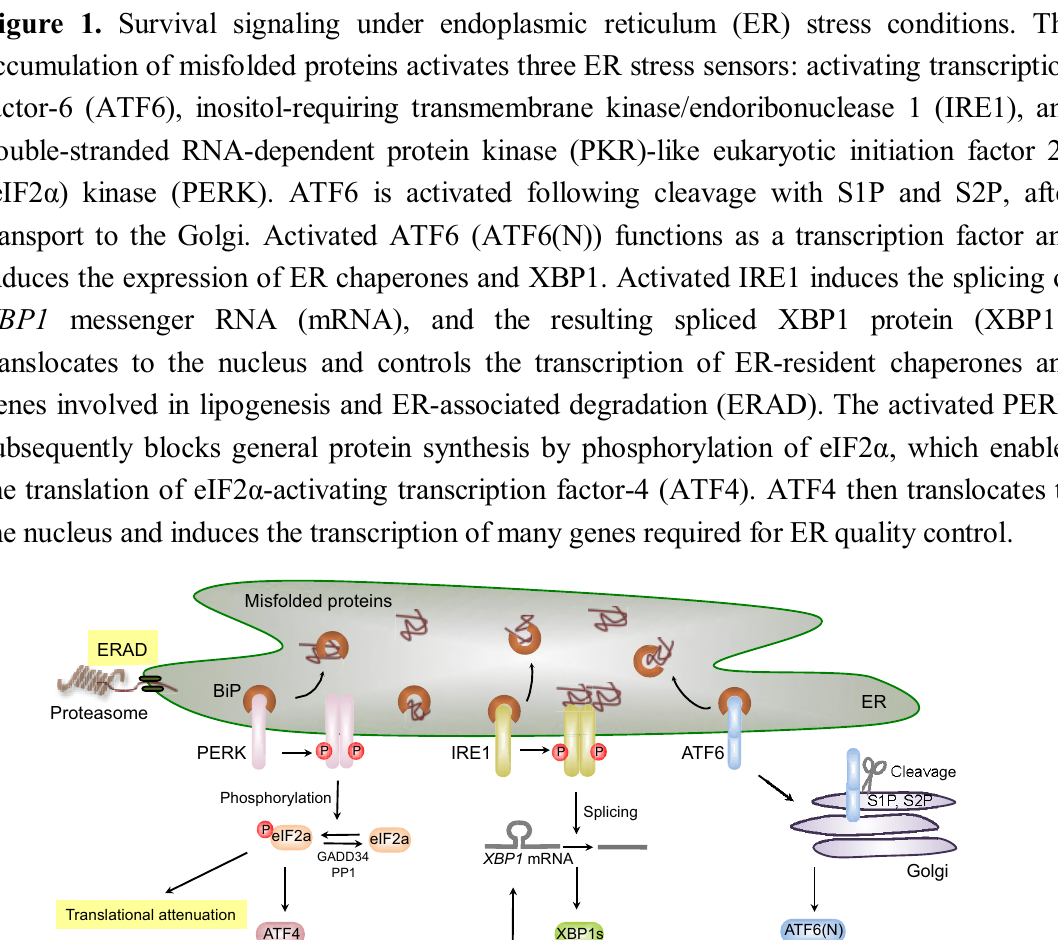
Figure 1. Survival signaling under endoplasmic reticulum (ER) stress conditions. The accumulation of misfolded proteins activates three ER stress sensors: activating transcription factor-6 (ATF6), inositol-requiring transmembrane kinase/endoribonuclease 1 (IRE1), and double-stranded RNA-dependent protein kinase (PKR)- (cid:79)(cid:76)(cid:78)(cid:72)(cid:3) (cid:72)(cid:88)(cid:78)(cid:68)(cid:85)(cid:92)(cid:82)(cid:87)(cid:76)(cid:70)(cid:3) (cid:76)(cid:81)(cid:76)(cid:87)(cid:76)(cid:68)(cid:87)(cid:76)(cid:82)(cid:81)(cid:3) (cid:73)(cid:68)(cid:70)(cid:87)(cid:82)(cid:85)(cid:3)